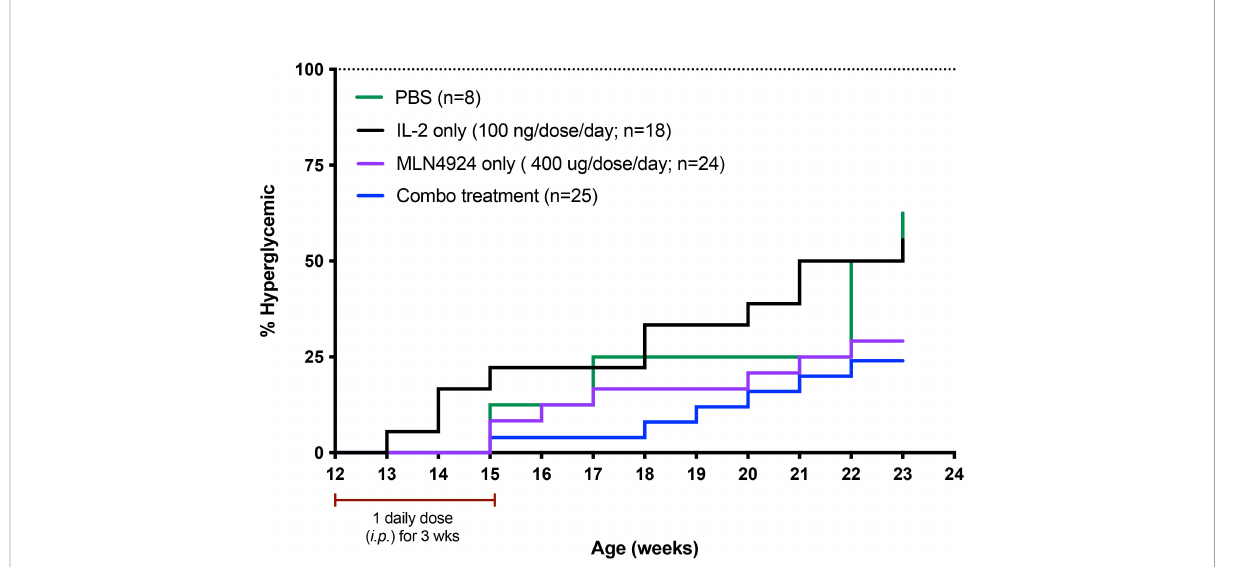
FIGURE 5 Use of the NAEi MLN4924 to treat NOD disease and undergoes receptor mediated endocytosis. IL-2 binding to the IL-2R triggers cellular pathways leading to second messenger signaling activity. Defective second messenger signal pathways identi fi ed in T regs from patients with autoimmune diseases that require inhibition of CRL activity, can be corrected by NAEi ’ s attached to the PDC by stable linkers that are enzymatically cleaved only inside the target cell to deliver the drug payload to the appropriate cell. B) PDC (ATA-003) consisting of 3 molecules of an NAEi (MLN4924) bound by di-peptide linkers to the thioredoxin portion of the murine IL-2 fusion